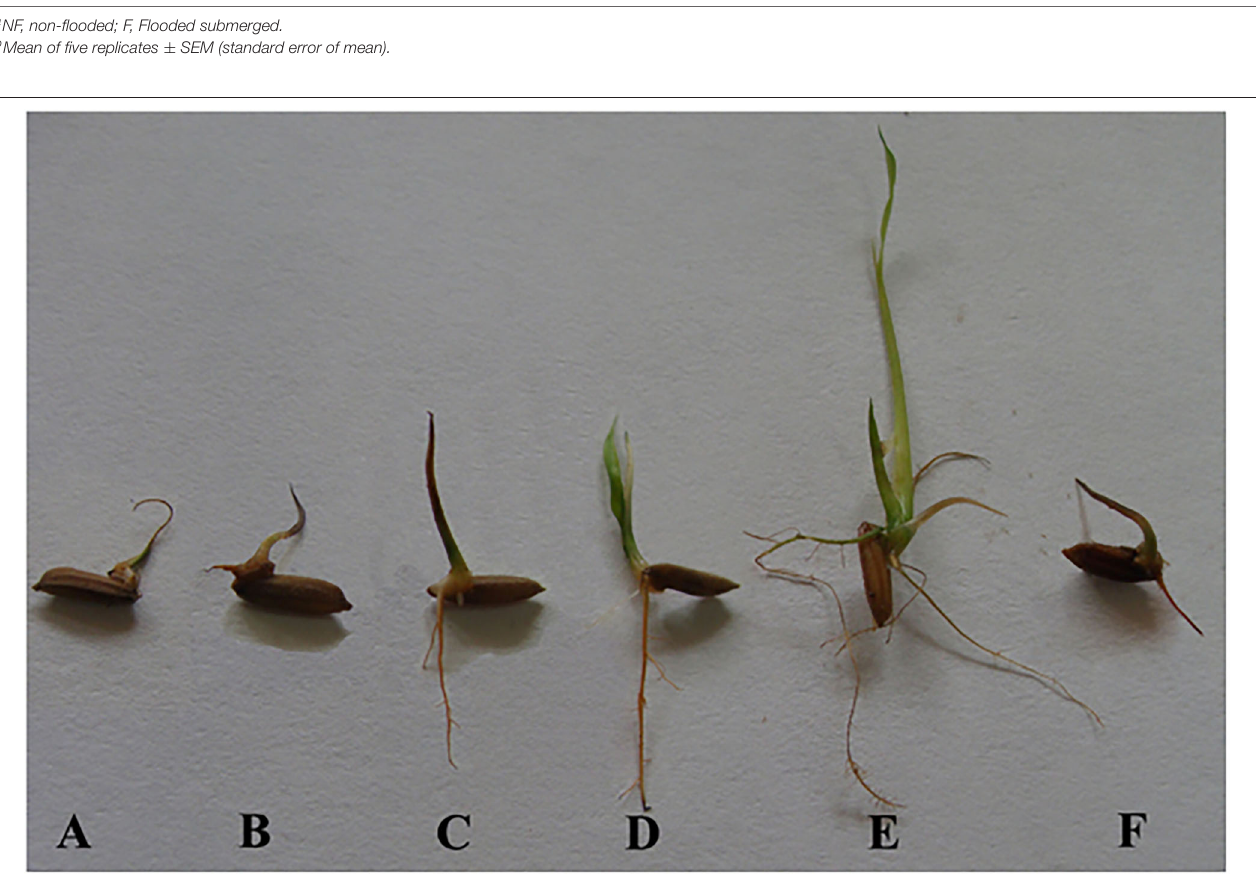
FIGURE 1 | Root and shoot growth of 7-day-old rice ( cv. IR-42) seedlings exposed to submergence stress under gnotobiotic conditions . (A) 0.03M MgSO 4 (negative control); (B) Bacillus sp. (AR-ACC1); (C) Methylophaga sp. (AR-ACC3); (D) Paenibacillus sp. (ANR-ACC3); (E) Microbacterium sp. (AR-ACC2); (F) AVG (positive